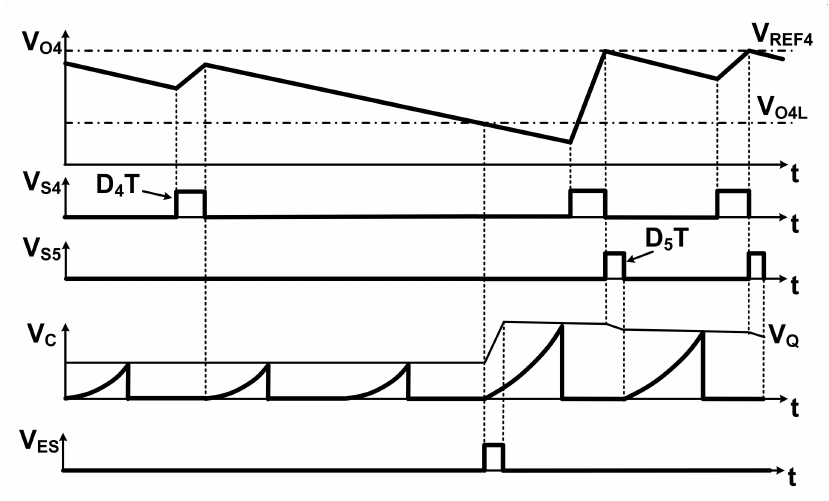
Figure 7. Timing diagram for low-to-high load